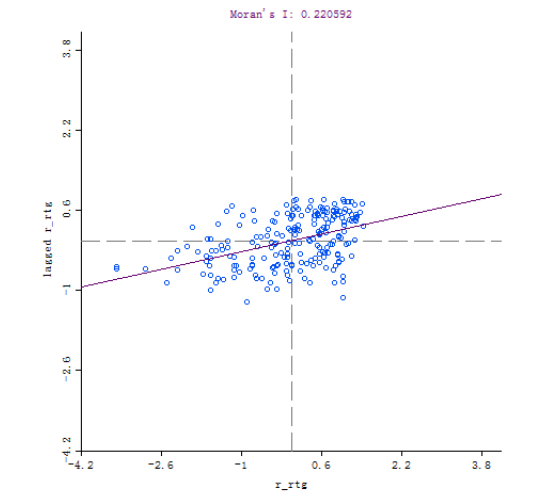
Figure 2. Results of Moran’s I. r_plr denotes contextual polarity; r_rtg denotes numeric rating